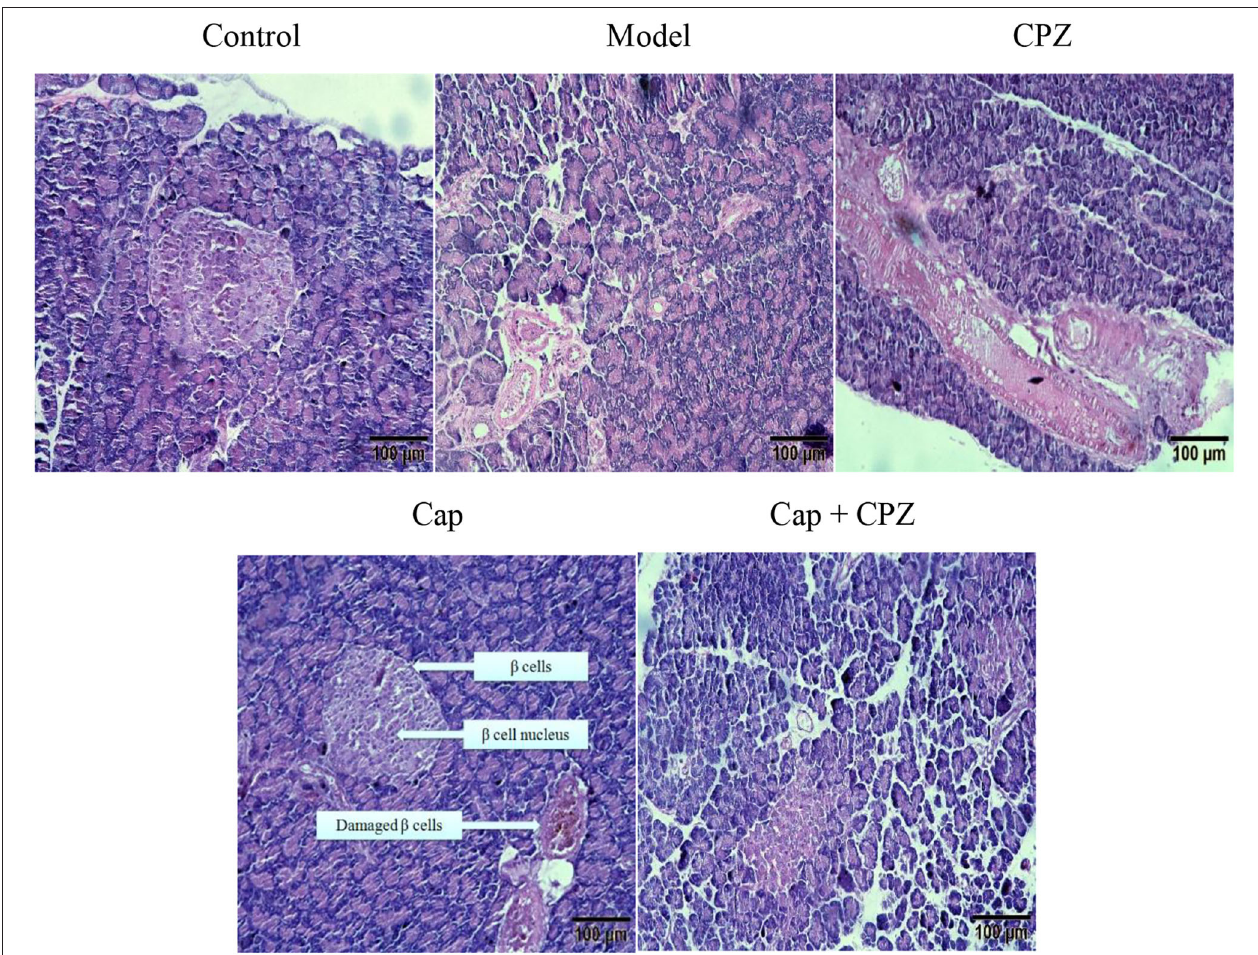
FIGURE 3 | Effects of TRPV1 Receptor Antagonist and Capsaicin on pancreatic tissue morphology in STZ-induced diabetic rats. Pancreatic tissue sections were stained with HE and photographed with a scale of 100 µ m. Effective concentrations of capsaicin and capsazepine are 6 and 10 mg/kg · BW, respectively.